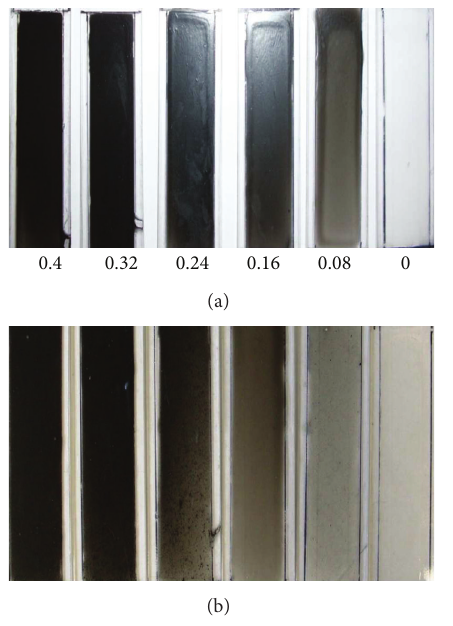
Figure 3: Photographs of coatings prepared with t-MWCNTs (a) and r-MWCNTS (b) at various loading levels.